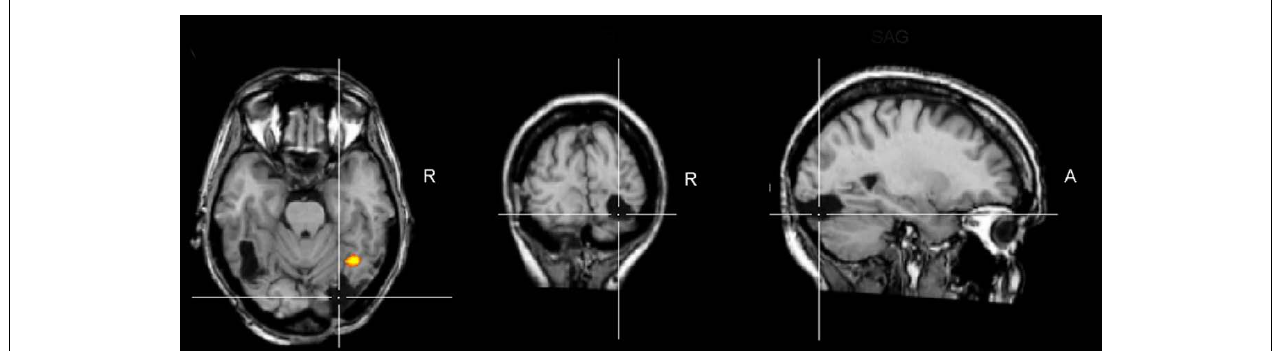
of a combined analysis of six functional localizer runs, contrasting faces and object pictures in a face localizer contrast, see Sorger et al., 2007 for details). Although this region responds preferentially to faces, it does not show the normal release to adaptation to different facial identities, in line with the difficulties of the patient in individualizing faces.TRA, transverse plane; COR, coronal plane; SAG, sagittal plane; R,